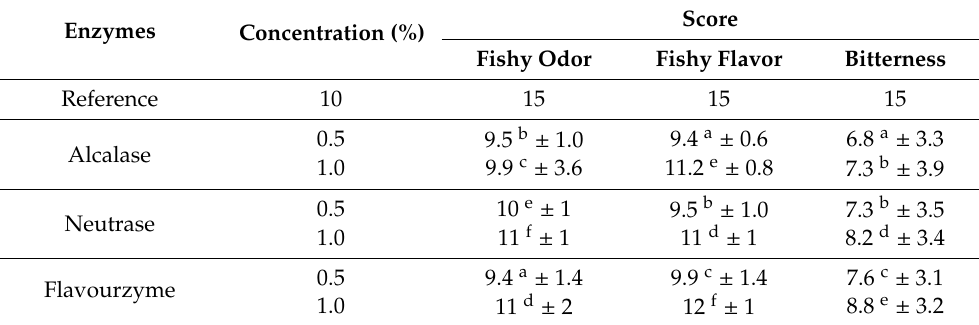
Table 6. Intensity score fishiness and bitterness from the sensory